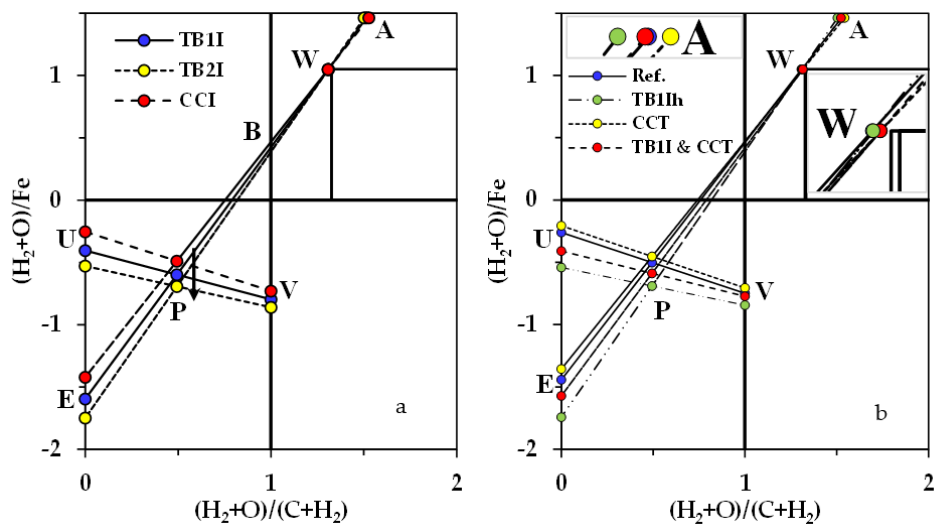
Figure 5. Rist diagrams of ( a ) TB1I, TB2I and CCI, ( b ) Ref., CCT and TB1I and CCT including zoomed section.